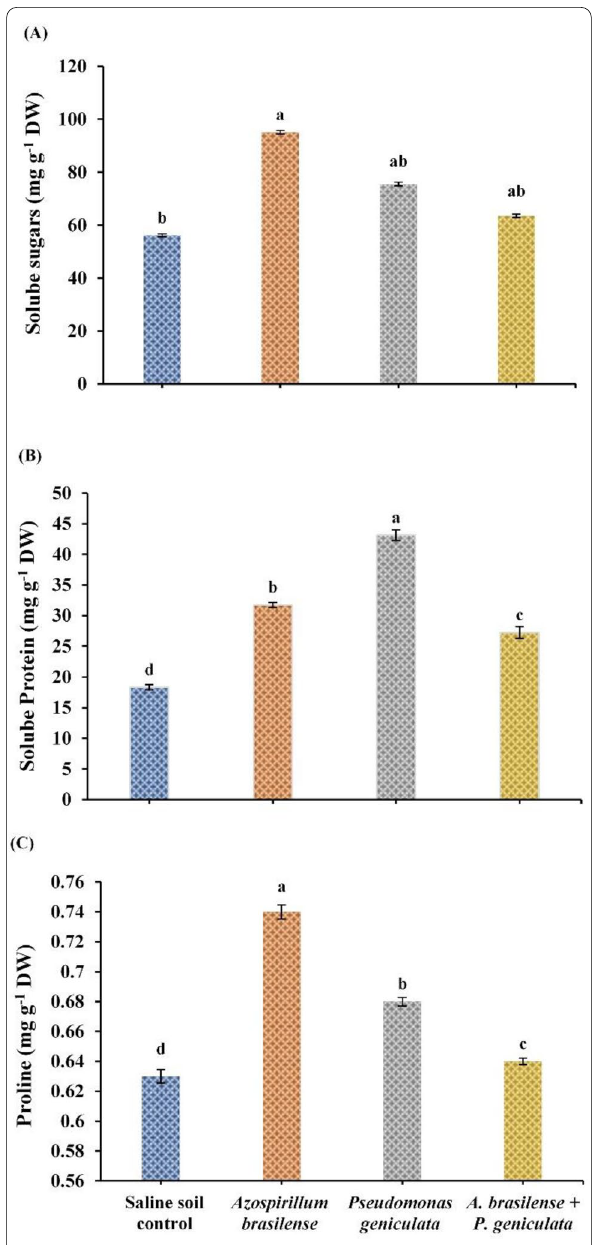
Fig. 3 Effect of the inoculation with Azospirillum brasilense , Pseudomonas geniculata individually or co-inoculation on Soluble sugars; Soluble protein and proline contents of flax plants ( Linum usitatissimum ) grown in saline soil. Bars represent the mean of three replicates (n 3), vertical bars indicate standard error. Different = ± letters indicate significant difference among means according to LSD test at p < 0.05. DW dry